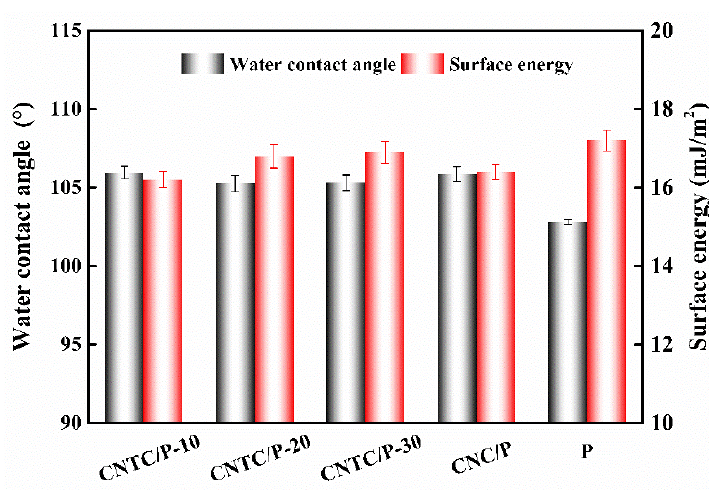
Figure 6. WCA and SE of studied coatings.